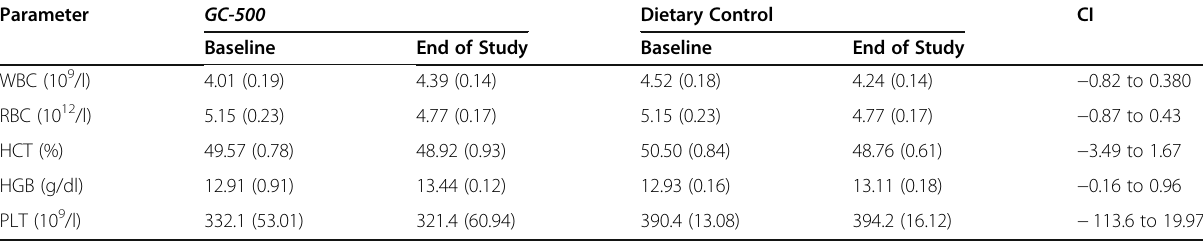
Table 4 Haematological Data of Participants from both groups during the Study Parameter GC-500 Dietary Control